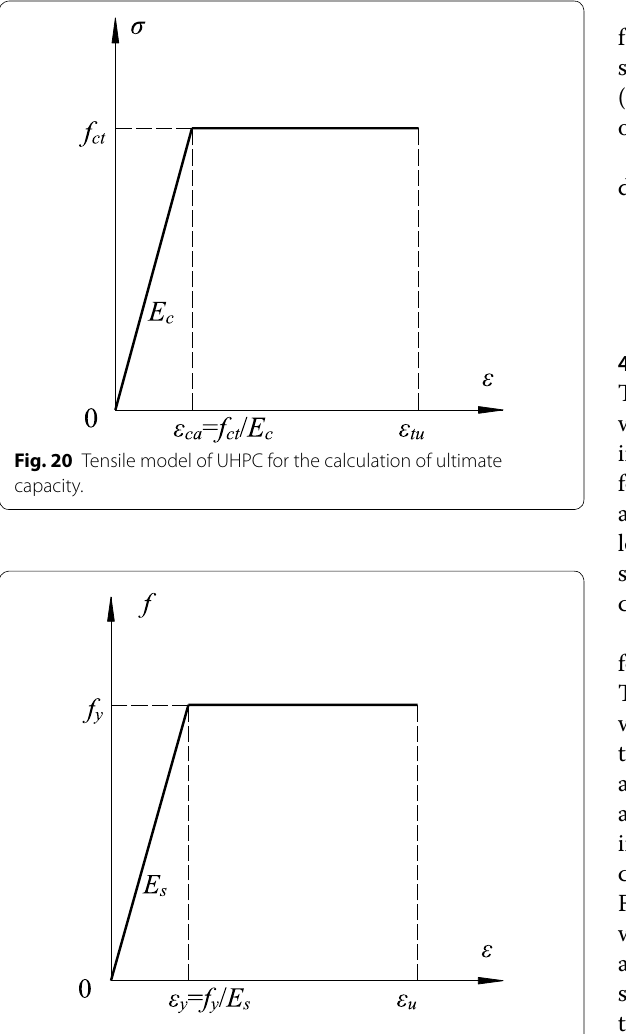
Fig. 21 Material model for reinforcement.